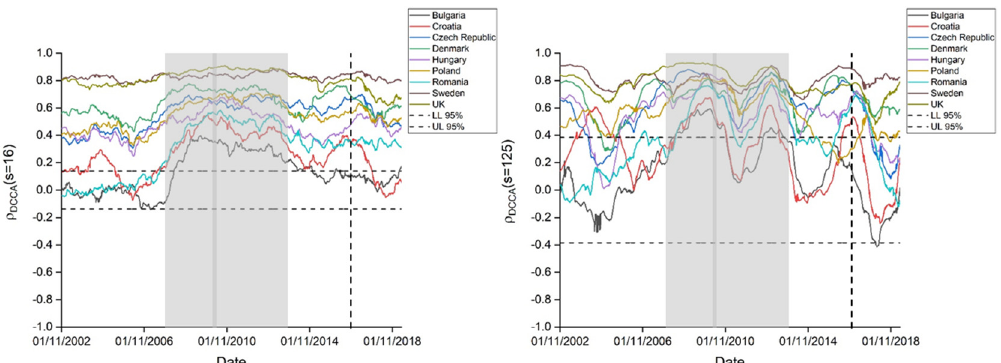
Figure A4. Evolution of ρ DCCA between non-Eurozone stock markets and Germany (time scales of 4, 8, 16, 32, 64, 125, and 250 days with a window size w = 500). LL and UL are, respectively, the lower and upper limits of the confidence interval. Shaded areas represent the global financial crisis and the Eurozone debt crisis. The vertical dashed line refers to the moment of the Brexit referendum.